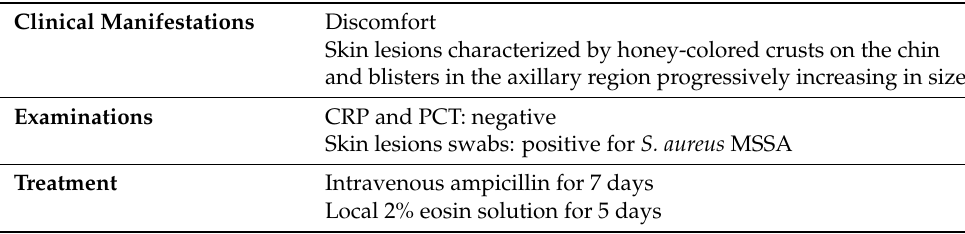
Table 3. Summary of case 2 with Staphylococcal scalded skin